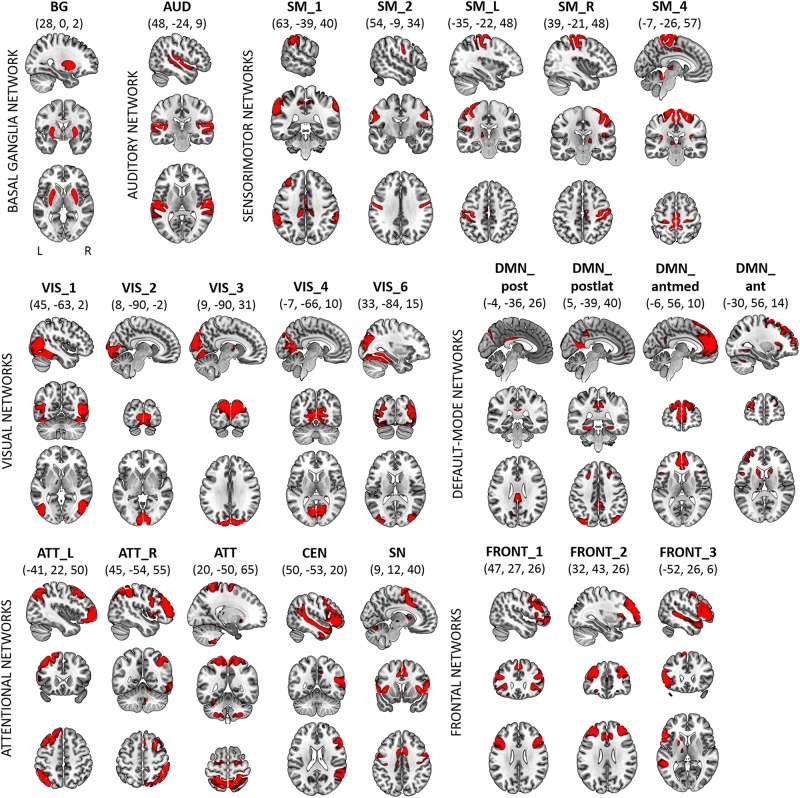
Dataset 1: Spatial maps (SMs) of the 24 independent components (ICs) identified as RSNs, obtained from spatial group-ICA performed by Human Connectome Project. SMs are plotted as z-scores and displayed at the three most informative slices (MNI-space). RSNs are categorized into groups according to their anatomical and functional properties. Spatial maps of RSNs were visualized with the mricrogl software (https://www.nitrc.org/projects/mricrogl).